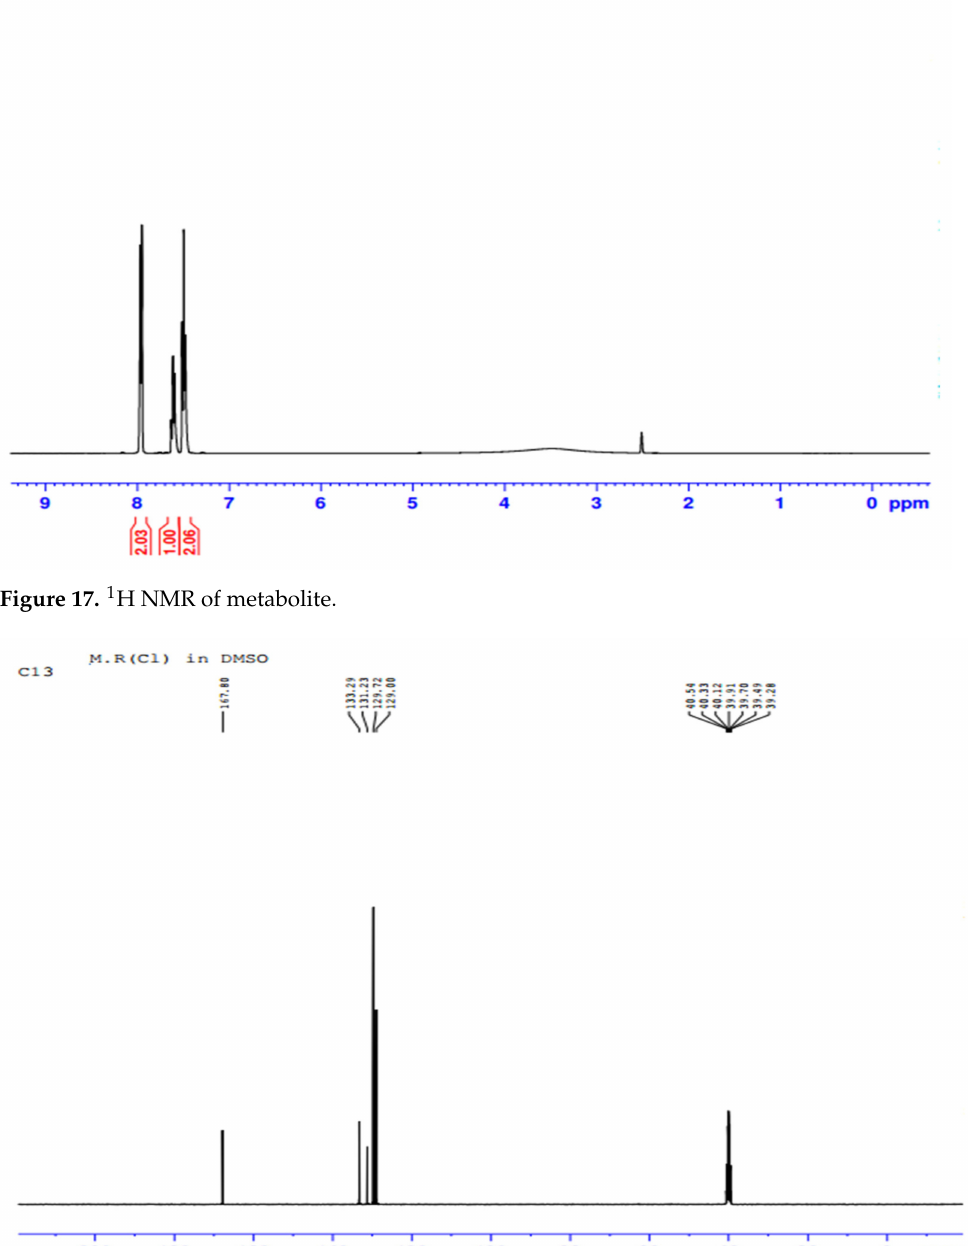
Figure 18. 13 C NMR of the